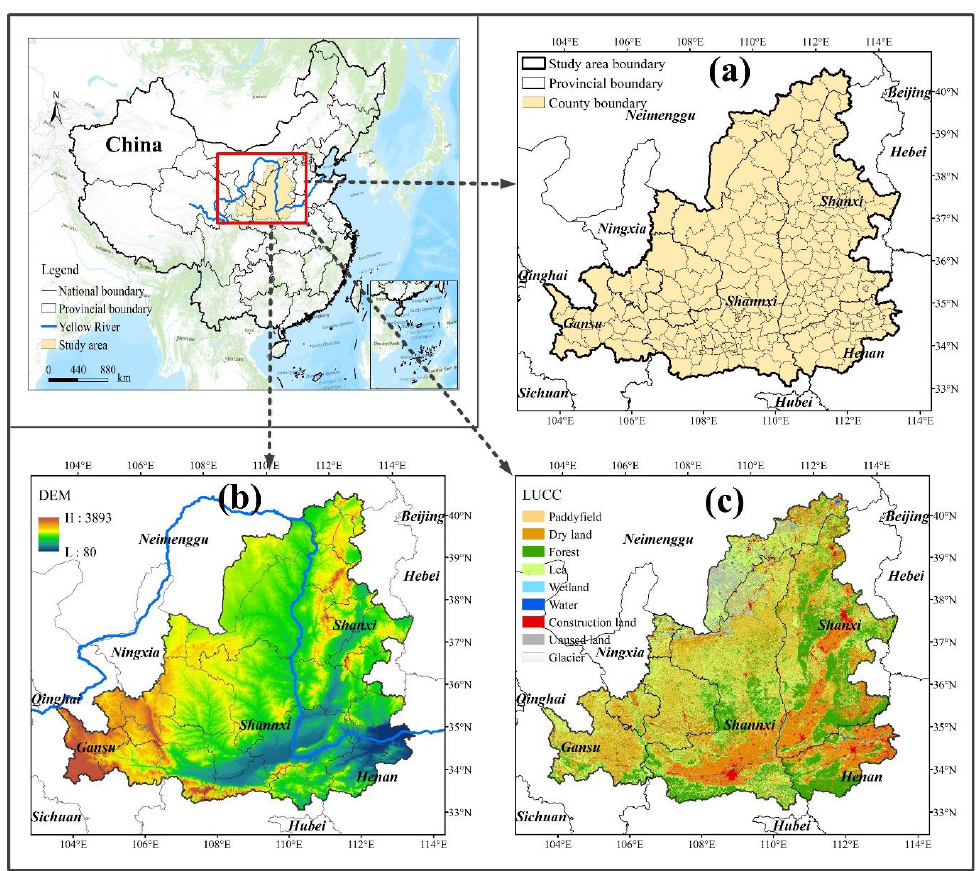
Figure 1. The Middle Reaches of the Yellow River (MRYR) in China, ( a ) Administrative division map of the MRYR, ( b ) Elevation distribution map of the MRYR, and ( c ) Land use distribution map of the MRYR in 2018.